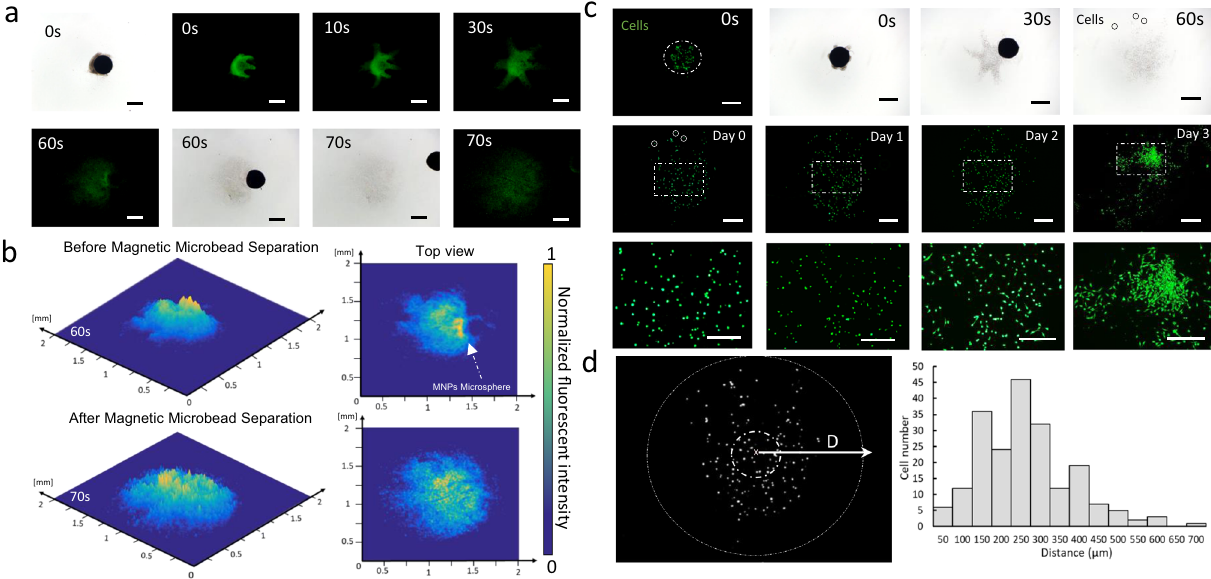
Fig. 7 In vitro delivery test. a Bright- fi eld and fl uorescent images showing the distribution of fl uorescent nanobeads encapsulated in an ISME and magnetic microsphere removal at 70 s. Scale bar: 500 μ m. b Intensity maps representing the distribution of fl uorescent nanobeads before and after magnetic microsphere separation at 60 and 70 s, respectively. c Bright- fi eld and fl uorescent images illustrating the dissolution of fl uorescent-stained cells encapsulated in the ISME and magnetic microsphere removal at 30 s; cell proliferation is shown over 3 days of cultivation. Scale bar: 500 μ m. d Gray-scale image representing the cell distribution on day 0 and quanti fi cation of the distances of the cells from the distribution center, which is evaluated in the histogram. Scale bar: 500 μ m. Source data is provided as a Source Data fi le.